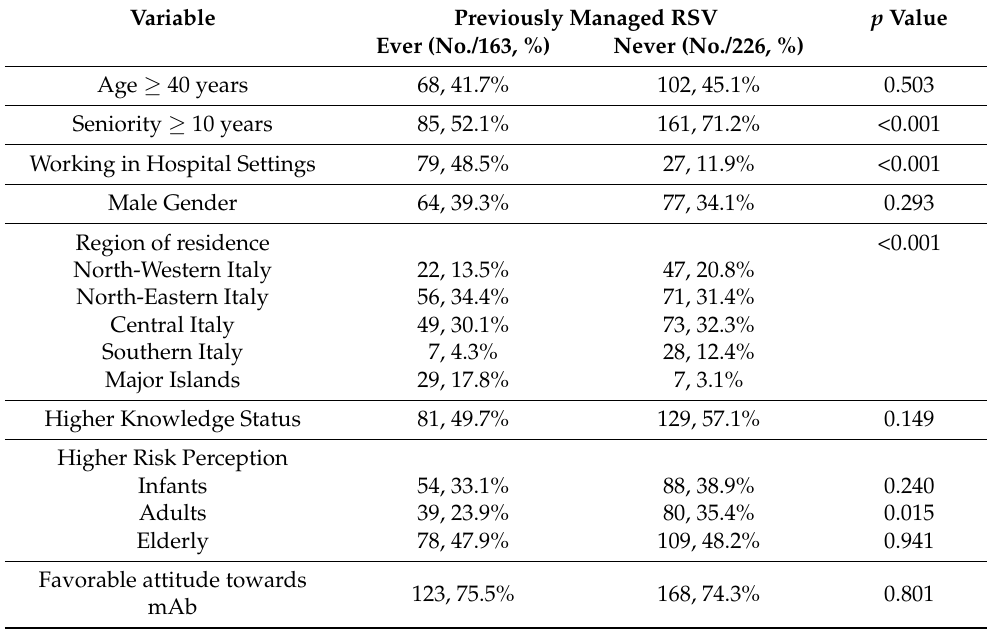
Table 3. Characteristics of the 389 Italian Pediatricians participating in the present survey on knowl- edge, attitudes, and practices on respiratory syncytial virus (RSV) by having or not having previously (i.e., in the previous 5 years) any cases of RSV in their